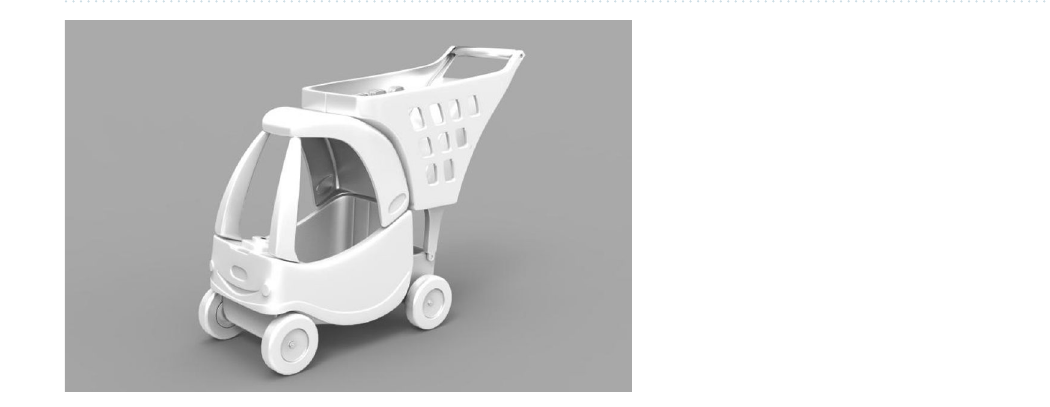
Figure 7. The 3D model of children’s shopping